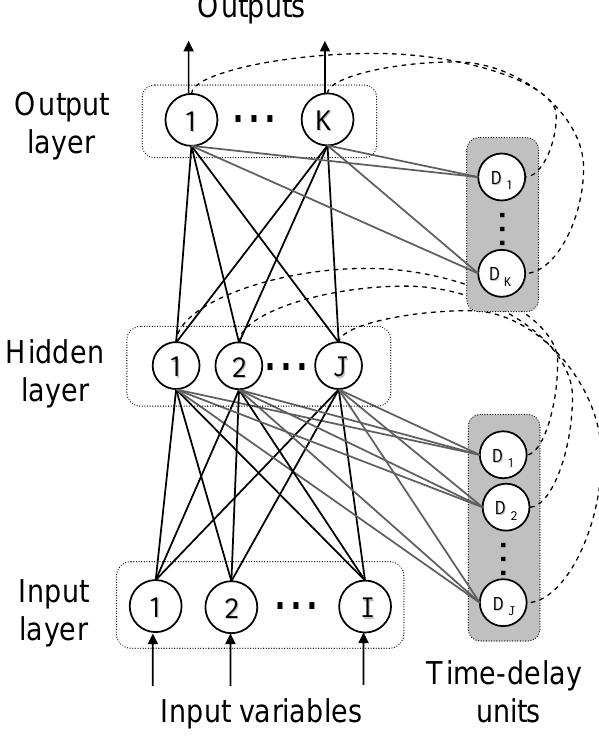
Fig. 1. The architecture of the recurrent neural network Figure 1 The architecture of the recurrent neural network (RNN) 640 641